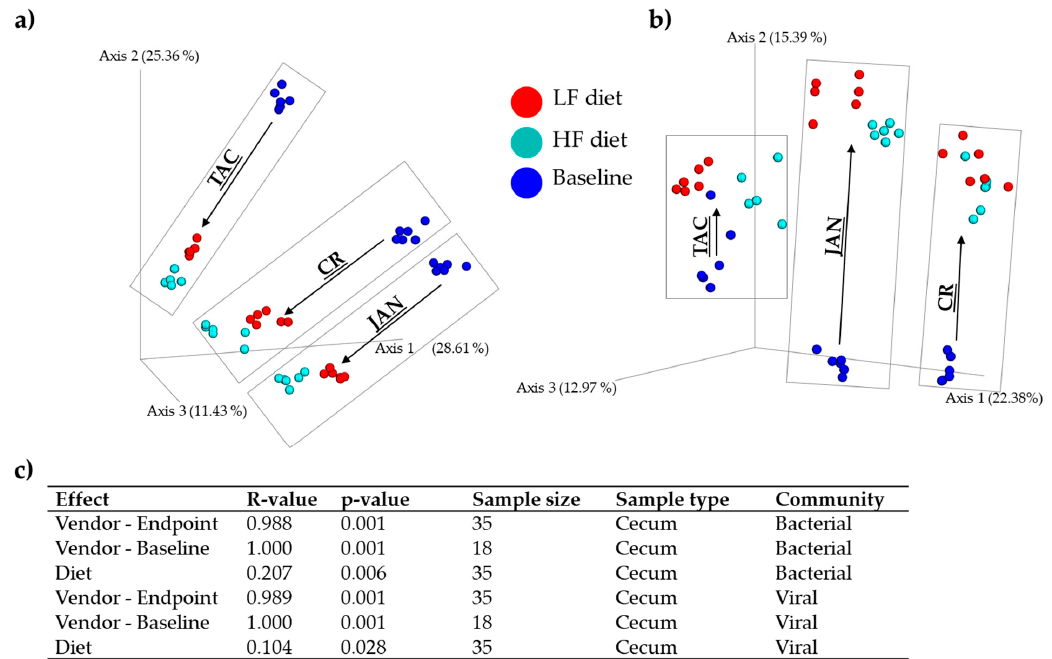
Figure 3. Bray–Curtis dissimilarity metric PCoA based plots of ( a ) the caecal bacterial community and ( b ) viral community at baseline (five weeks of age) and at endpoint after 13 weeks on low-fat or high-diet (18 weeks of age), respectively. ( c ) ANOSIM of the Bray–Curtis distances of the effects of diet and vendor at baseline and endpoint. Grey boxes frame the samples associated with the mice vendor. LF = low-fat diet, HF = high-fat diet, CR = Charles River, JAN = Janvier, TAC = Taconic.